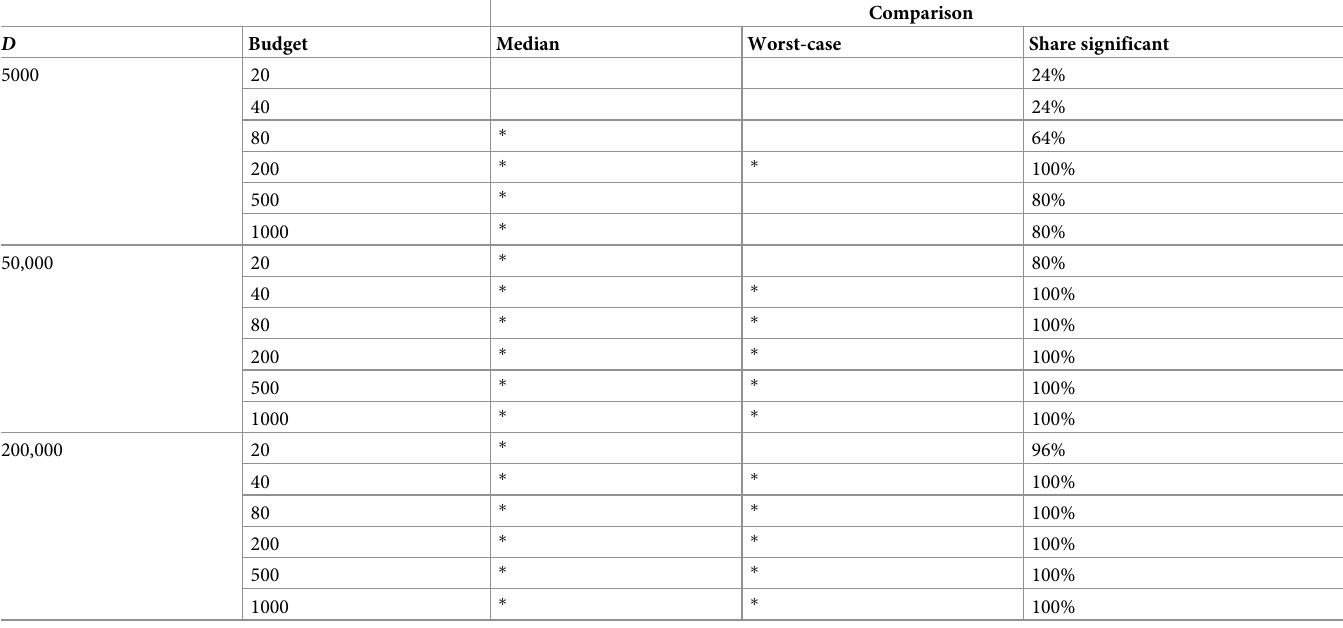
Table 2. Statistical comparisons of total error rate for “sample size”-adjusted dedupe and default dedupe.